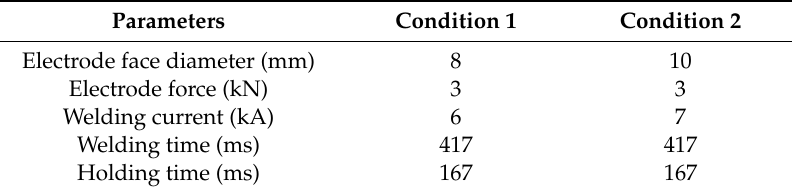
Figure 1. Schematic images of ( a ) electrode shape and ( b ) specimen size. Table 3. Resistance spot welding conditions used in this study.